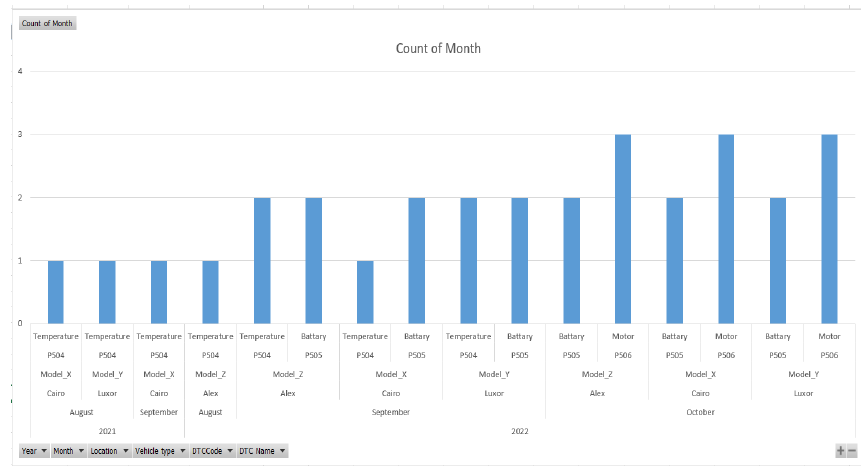
Figure 25. The history for many vehicle models and all logged DTC with timeline (used by the OEM for analysis of performance).